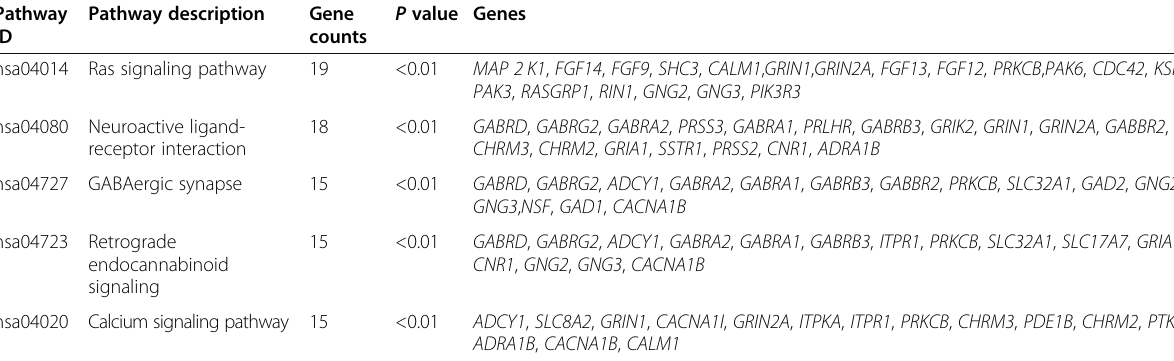
Table 1 KEGG pathway analysis of differentially expressed genes in MTLE-HS Pathway Pathway ID